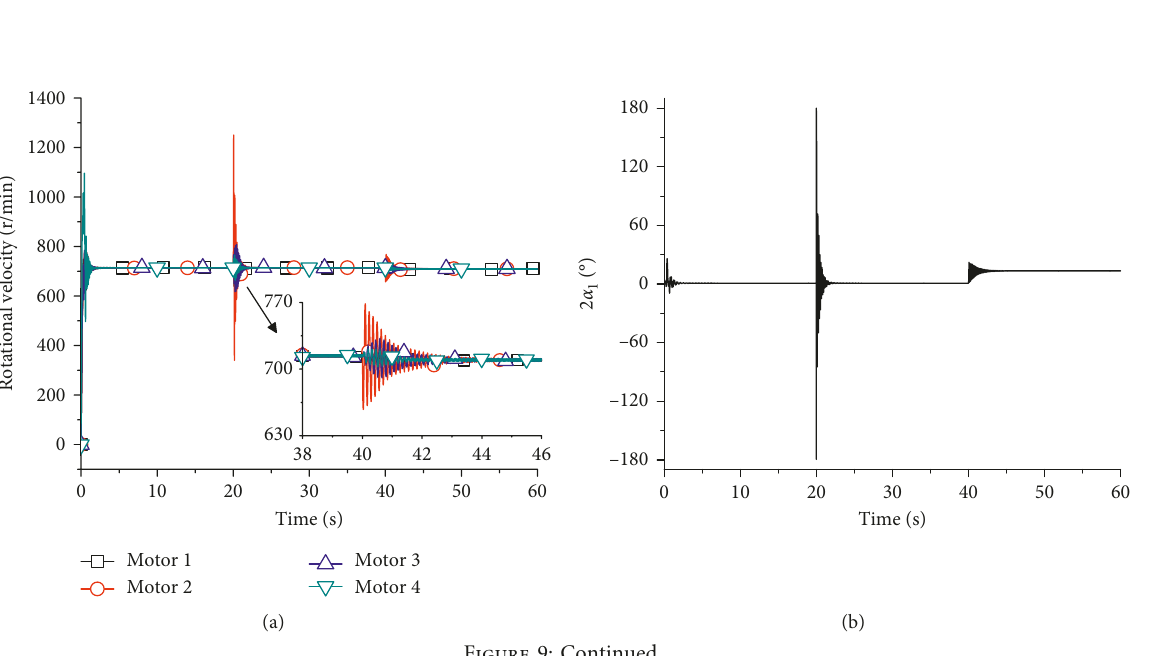
1 (cid:31) η 2 (cid:31) η 3 (cid:31) η 4 (cid:31) 1.